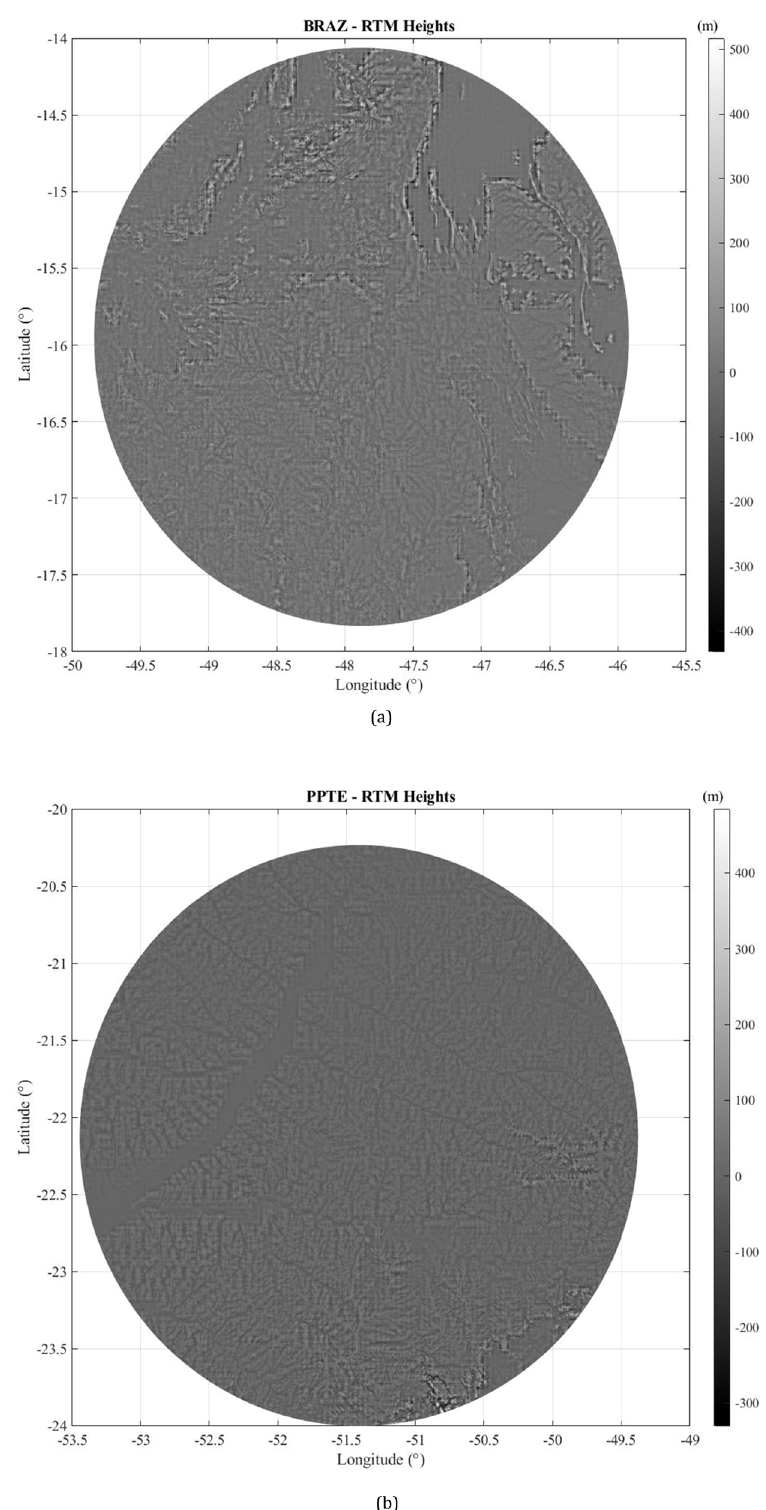
Figure 6: Residual DEM around ( a ) BRAZ and ( b ) PPTE